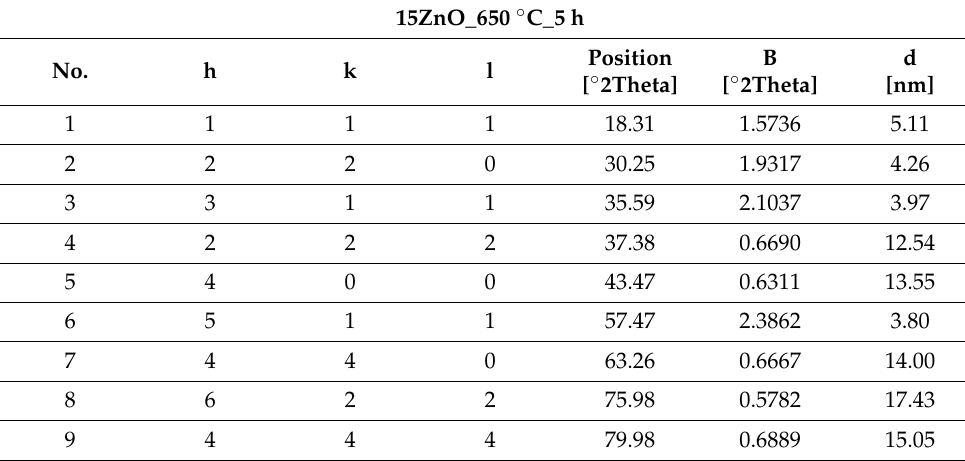
Table 4. Crystallography data for co-doped 15ZnO_650 ◦ C_5 h sample.